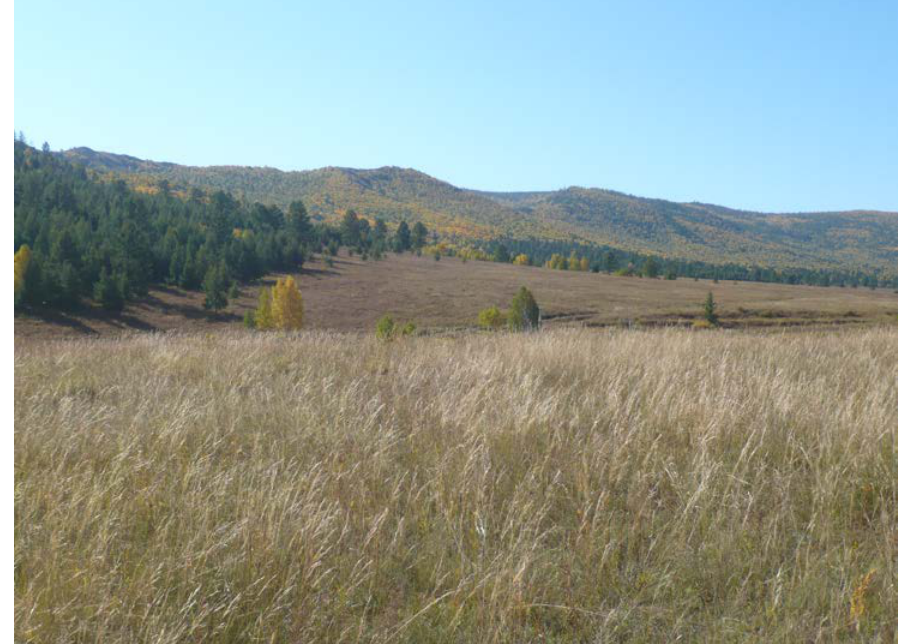
Figure A1. The research area Altansumber.